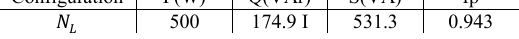
Table III. Active, Reactive and Total Power and Power Factor in 𝑀 1 𝑓𝑜𝑟 𝑁 𝐿 . Configuration